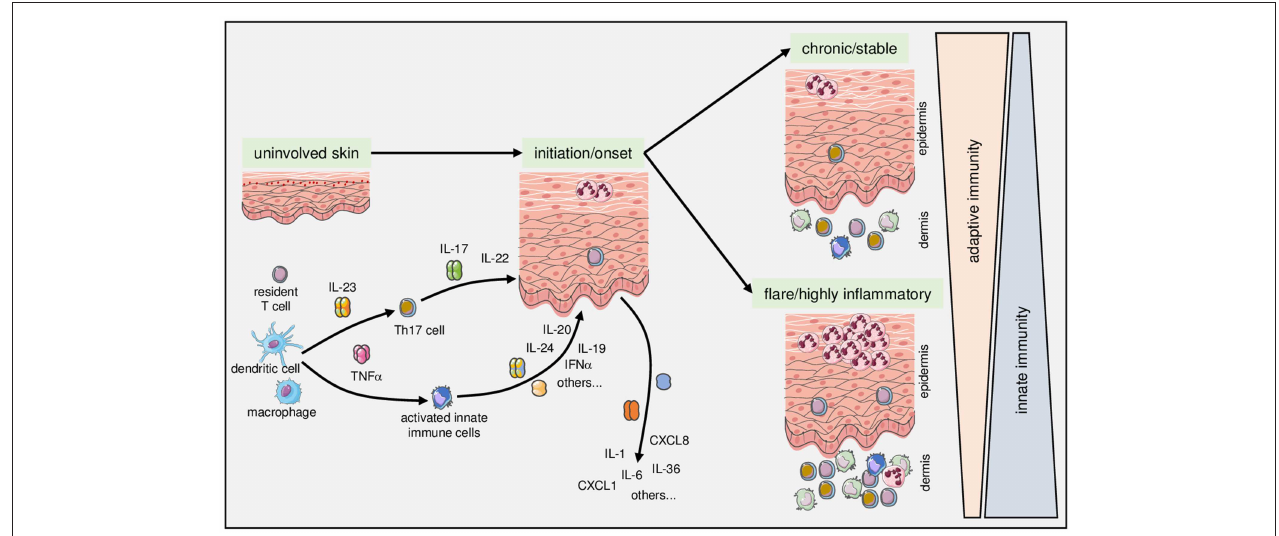
FIGURE 1 | Complex fine-tuning of innate and adaptive immune mechanisms determines onset, course, and activity of psoriasis. As detailed in the text, intricate interactions between components of the innate (exemplified here by dendritic cells and macrophages) with components of the adaptive immune system (exemplified here by T cells) lie at the core of the pathophysiology of psoriasis. Once established, the relative contribution and fine-tuning of various mediators of adaptive and innate immunity determine the clinical manifestation toward chronic stable vs. highly inflammatory and/or pustular